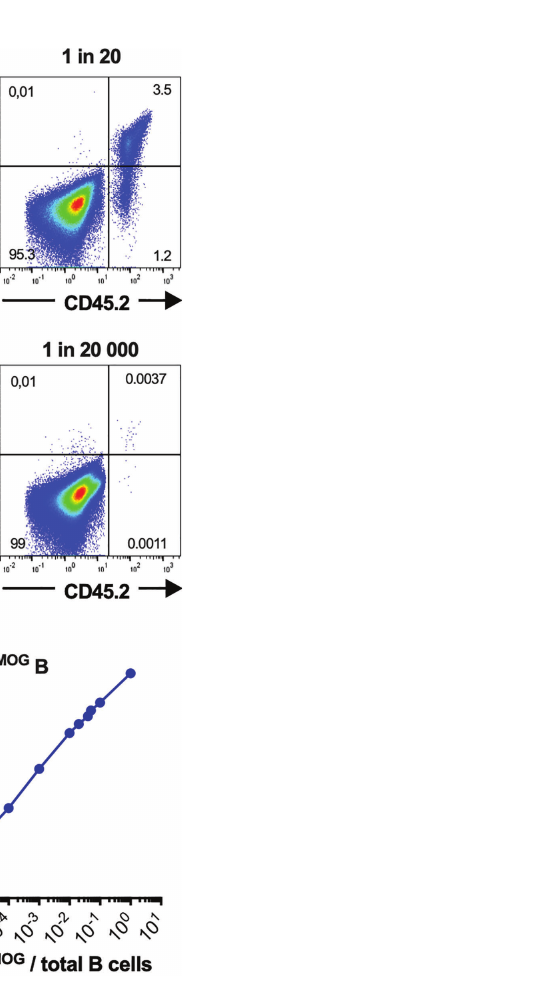
MOG + B cells remained relatively stable over time while the tet precursor frequency of MOG + tet B cells in the cervical lymph nodes was more varied ( Figures 5E, F ). This dataset is coherent with the activation of MOG-speci fi c B cells in the brain-draining cLN prior to in fi ltration of the in fl amed brain.